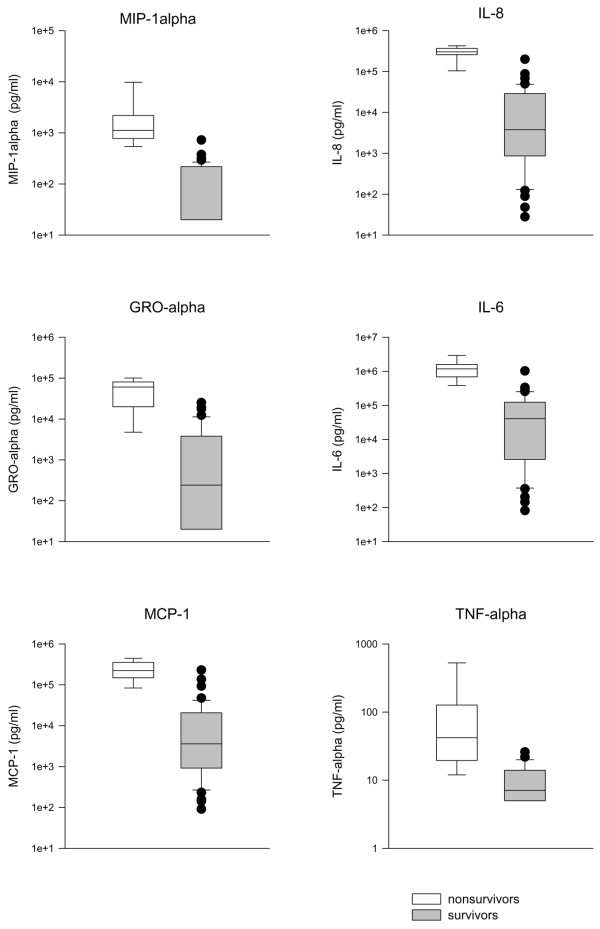
Levels of growth-related gene product alpha (GRO-α), monocyte chemoattractant protein 1 (MCP-1), macrophage inflammatory protein 1α (MIP-1α), IL-8, tumor necrosis factor alpha (TNF-α) and IL-6 in survivors versus nonsurvivors of meningococcal sepsis or septic shock. Black lines in boxes represent median values, boxes represent interquartile ranges, bars represent the 10th and 90th percentiles, and black dots are outlying values.